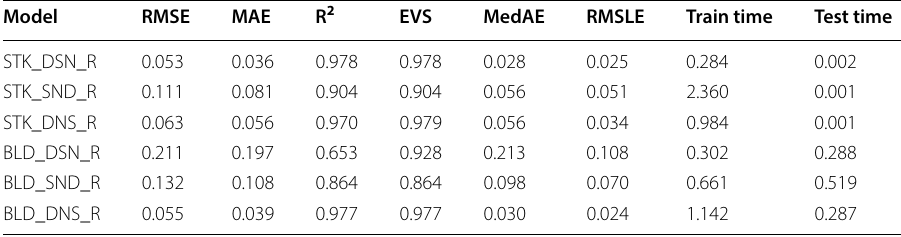
Table 22 Stacking and blending ensemble regressors error metrics result on BSE dataset Model